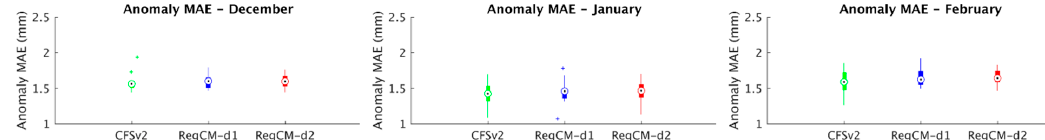
Table 2. Mean absolute error (MAE) for daily accumulated precipitation climatological period, 50 th and 95 th percentiles, and inter-annual anomaly variability for the three SFSs compared to the reanalysis. In the rightmost column the standard represents the ensemble spread from the ensemble mean anomaly MAE. The four metrics are averaged over the winter season. Units are mm/day. See text for details.